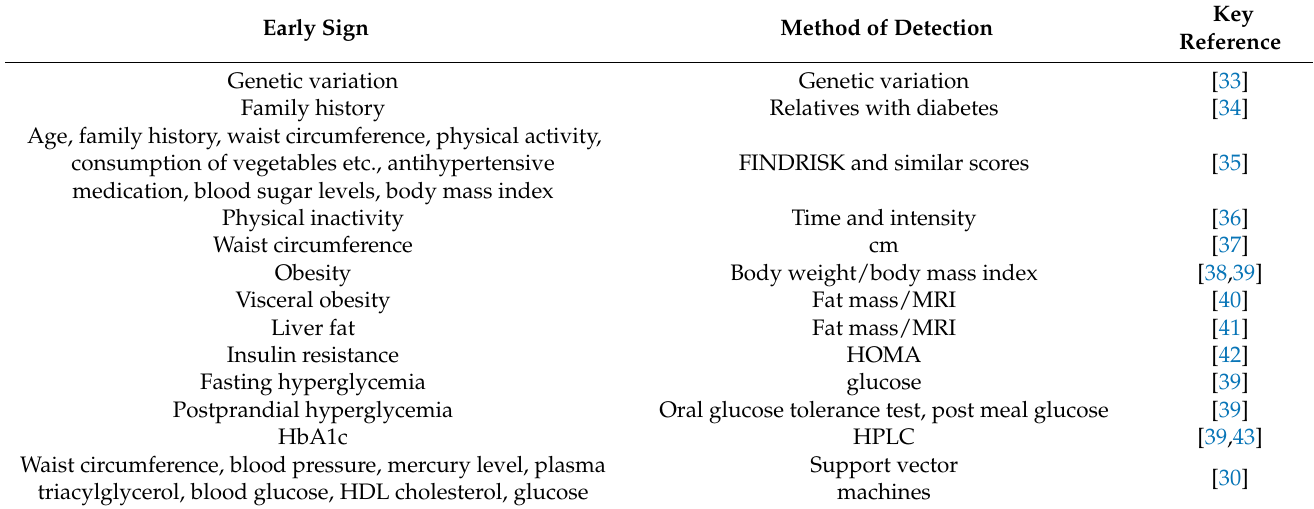
Table 1. Summary of existing solutions for early diagnosis of diabetes mellitus type